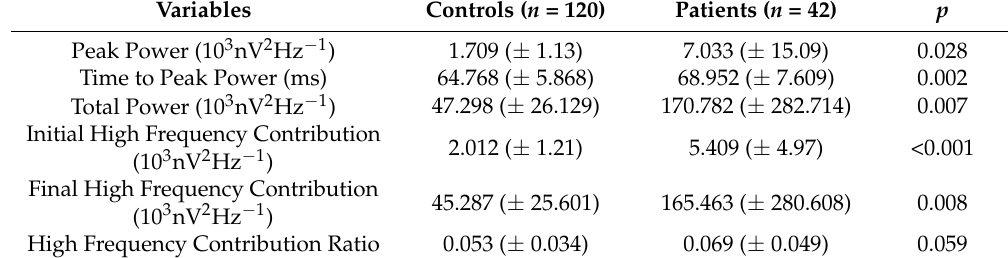
Table 3. Summary of high-frequency analysis.